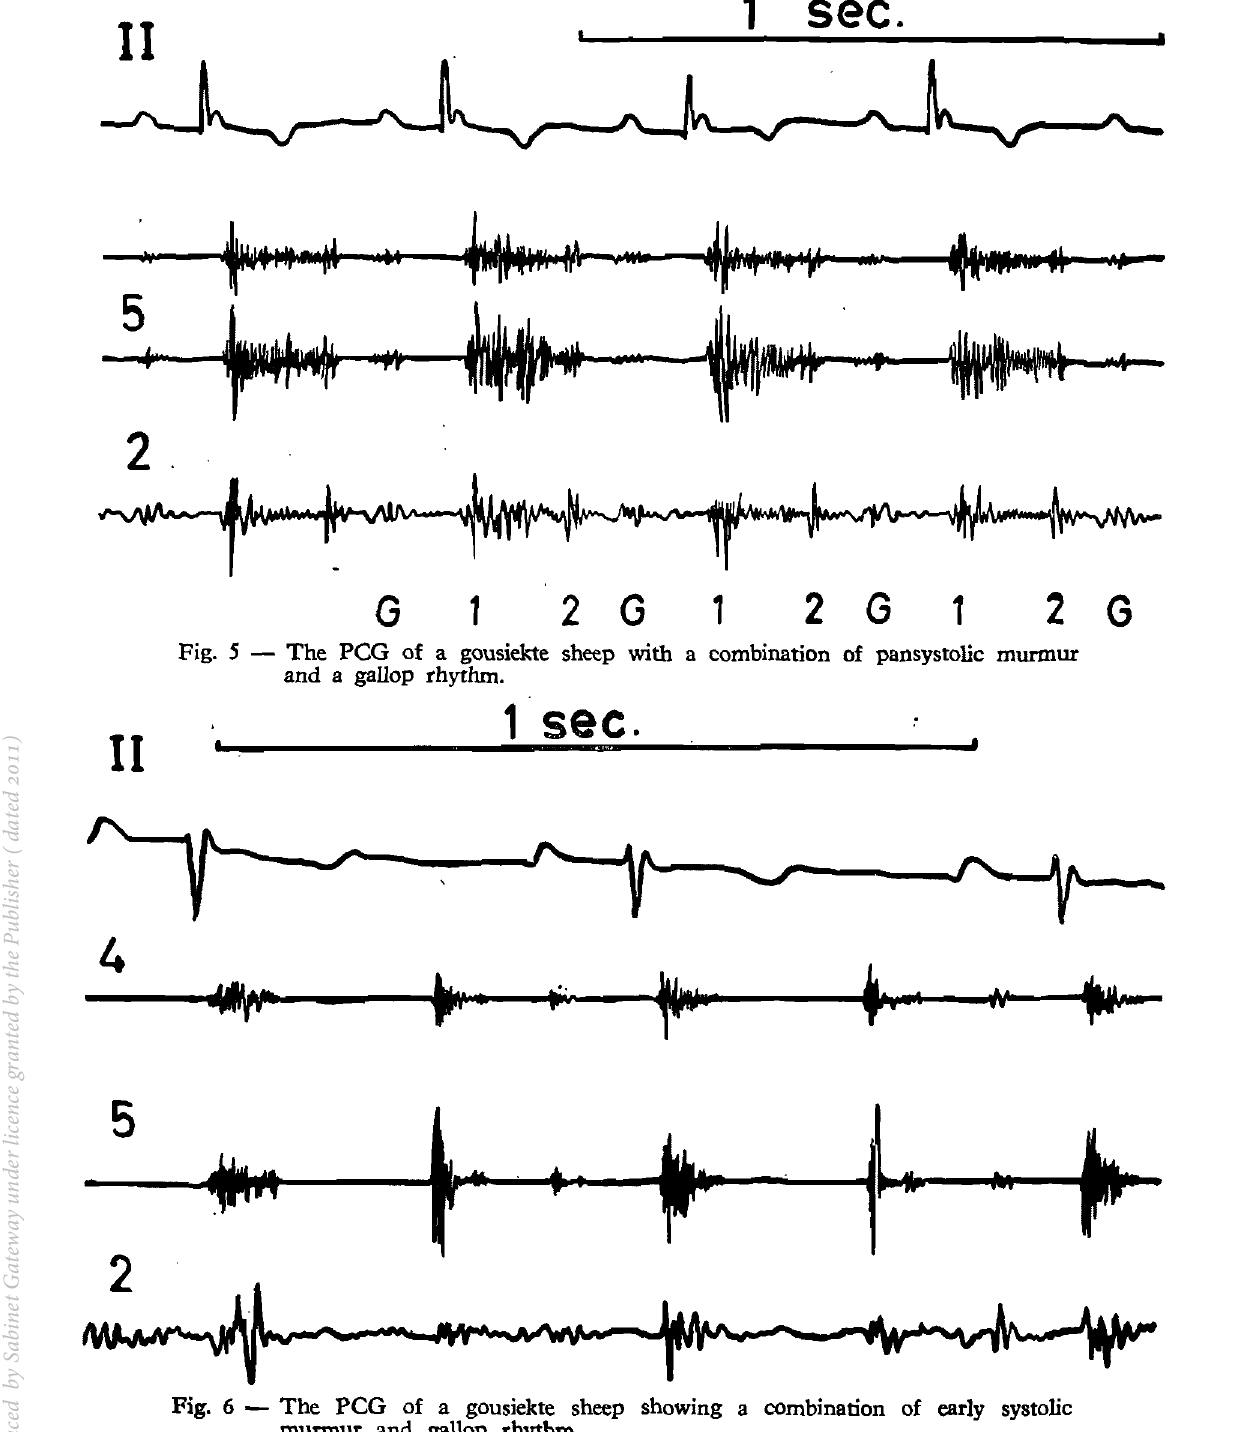
Fig. 6 - The PCG of a gousiekte sheep showing a combination of early systolic murmur and gallop rhythm.